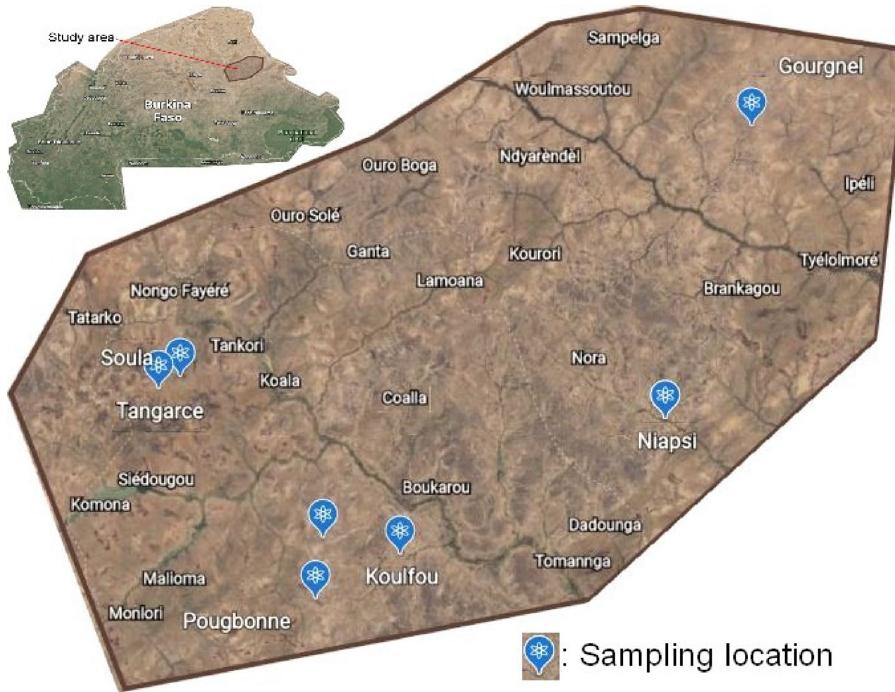
Fig. 1 Study area and sample